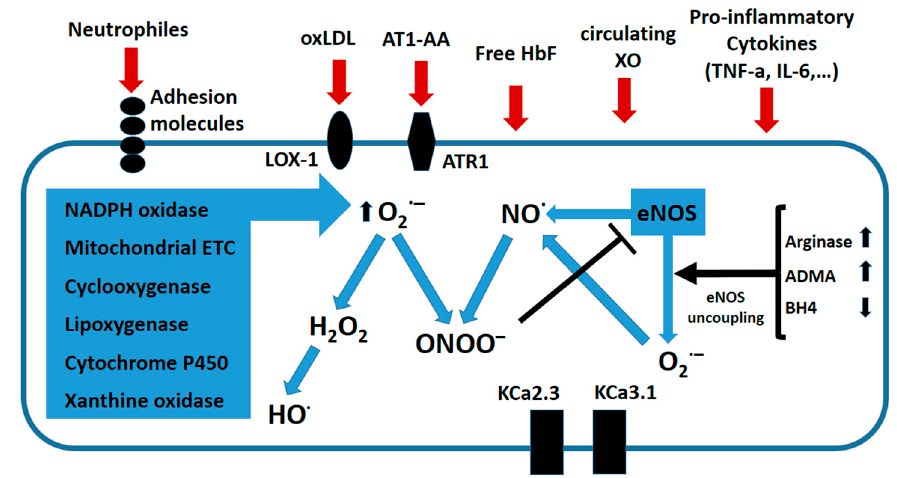
Figure 4. Principal mediators and sources of oxidative stress in the preeclamptic endothelium. Circulating factors in the blood of preeclamptic women can act on endothelial cells (ECs) to induce oxidative stress. These include reactive oxygen species (ROS) produced by neutrophils (oxLDL), agonist autoantibodies against angiotensin receptors (AT1-AA), free fetal hemoglobin (HbF), circulating Xanthine oxidase (XO), and cytokines (i.e., TNF- α ). In ECs, several enzymatic systems including the electron transport chain, NADPH oxidases, and cyclooxigenases can produce superoxide (O 2 •− ). Under certain circumstances, this can lead to increased Arginase II expression, increased asymmetric dimethyl arginine (ADMA), and the loss of the cofactor tetrahydrobiopterin (BH4), and endothelial nitric oxide synthase (eNOS) synthase can become uncoupled. Instead of • NO, uncoupled eNOS produces (O 2 •− ). Nitric oxide can then react with O 2 •− to produce peroxynitrite (ONOO − ), a powerful oxidant whose nitrate proteins can induce DNA damage. Additionally, ONOO − can inhibit eNOS activity. Superoxide scavenging of • NO impairs endothelium-dependent vasodilation. ROS can also down regulate the calcium-activated potassium channels KCa2.3 and KCa3.1, which are important electrical triggers of vasodilation. Figure adapted from [105].